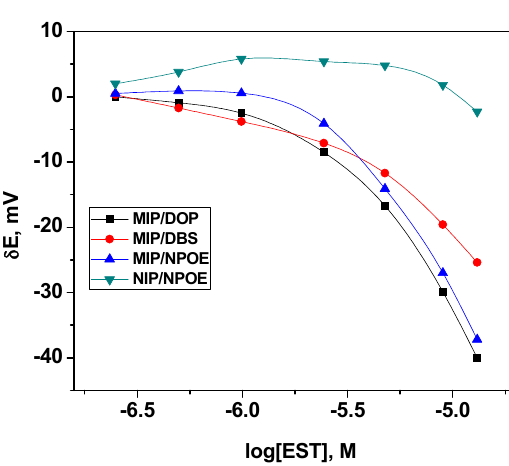
Figure 3. E ff ect of plasticizer type on the membrane Figure 3. Effect of plasticizer type on the membrane response.